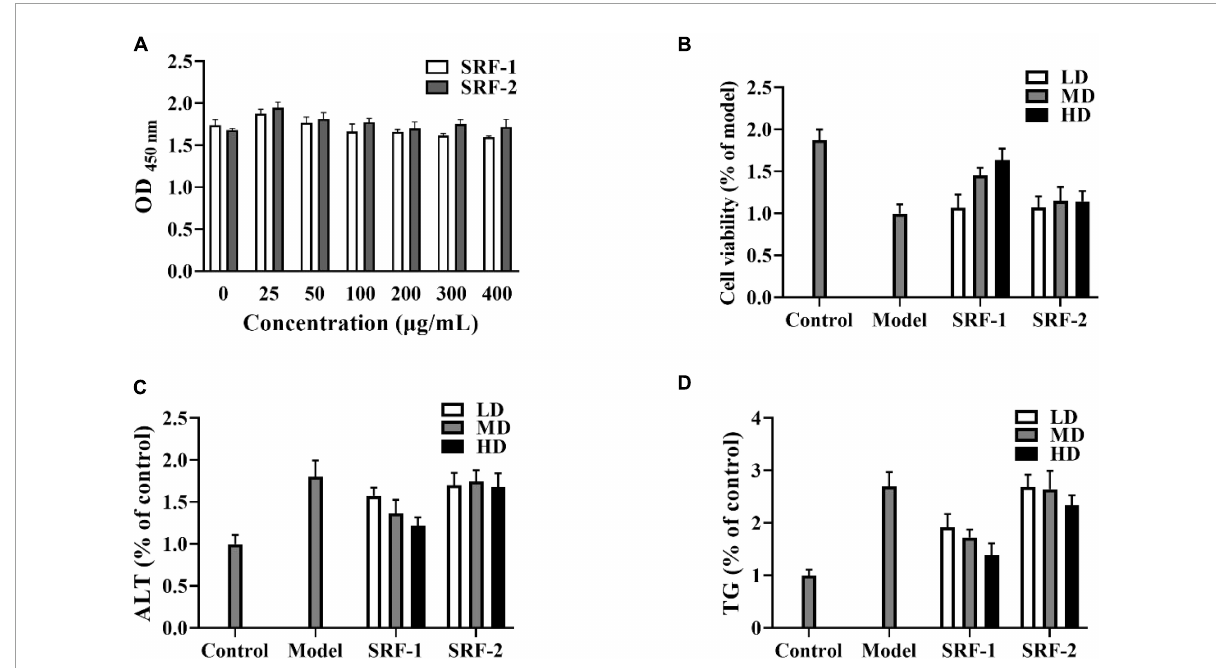
FIGURE2 Effects of SRF-1 and SRF-2 on FFA-induced HepG2 cells. (A) Cell viability of HepG2 cells. (B) Cell viability of FFA-induced HepG2 cells. (C) Extracellular ALT levels. (D) Intracellular TG levels.